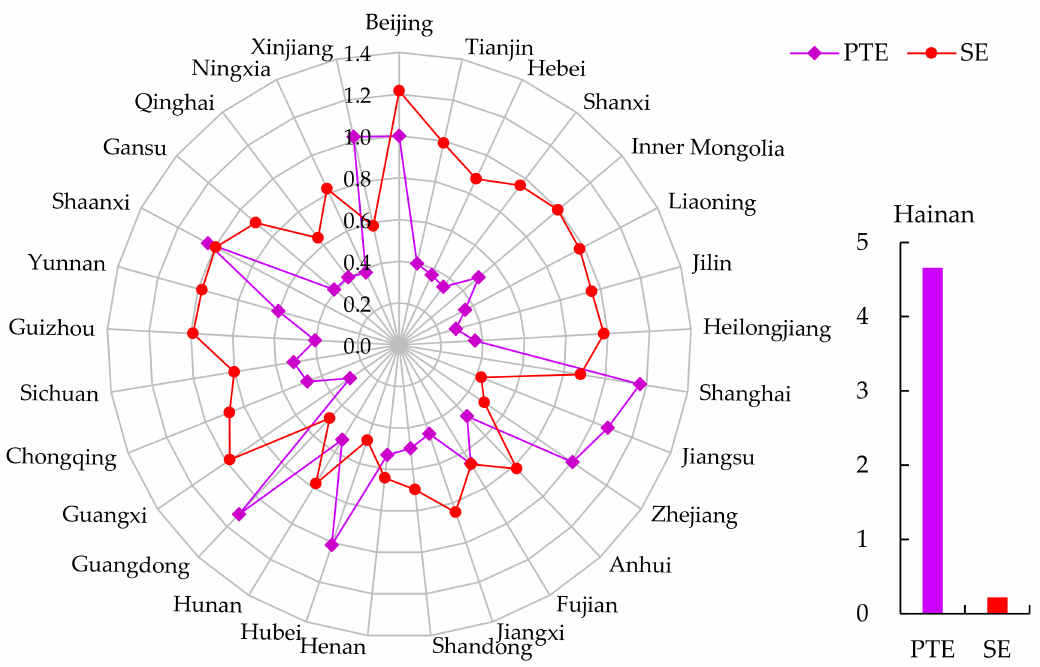
Figure 4. The pure technical efficiency (PTE) and scale efficiency (SE) of the industrial sector in various provinces in 2017. The PTE of Hainan Province is too large to display in the figure on the left, which would affect the display effect of the data of other provinces. Therefore, it is independently displayed in the bar chart on the